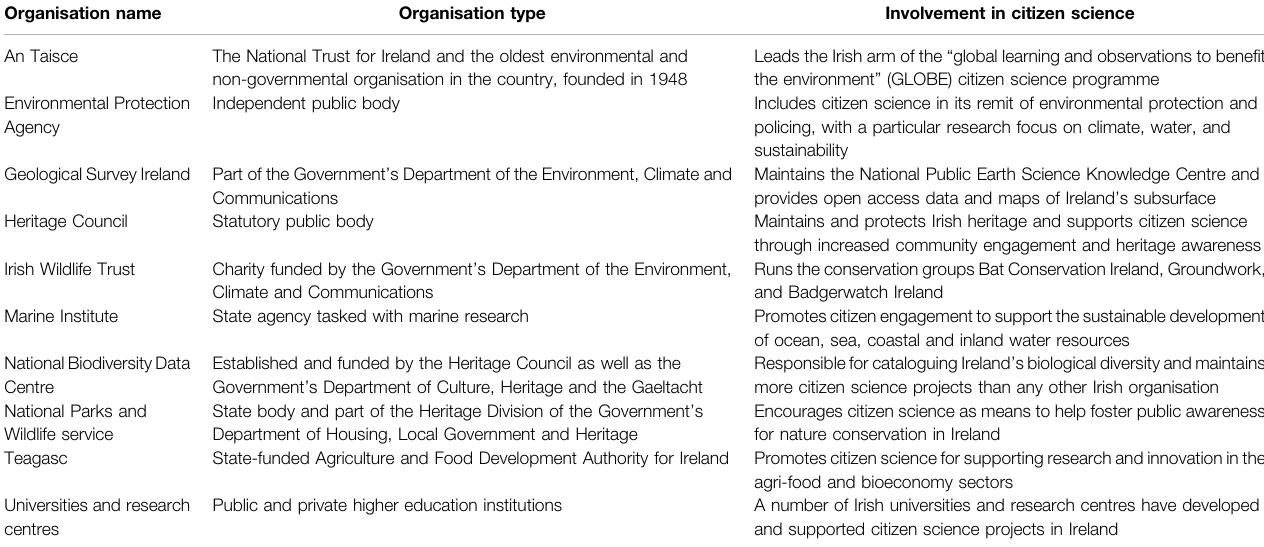
TABLE 1 | Organisations involved in citizen science in